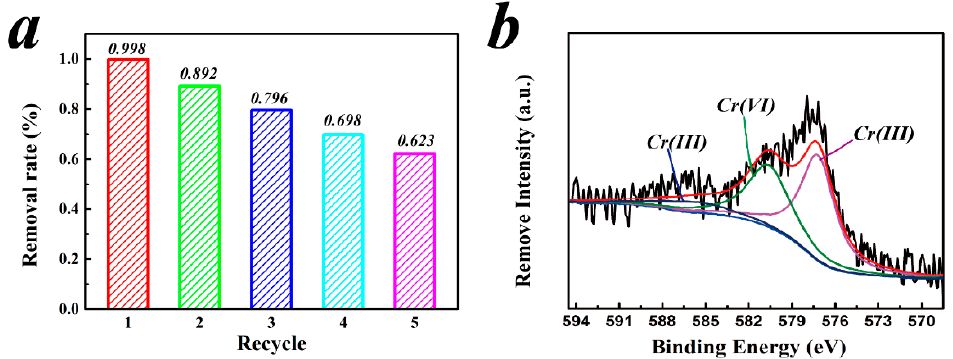
Figure 6. ( a ) The reusability of synthetic catalysts by 5 recycle on Cr(VI) removal (using the Ag@TiO 2 with 0.06 wt %); ( b ) High resolution XPS of Cr on the surface of Ag@TiO 2 catalyst. The experimental conditions were [Cr(VI)] 0 = 10